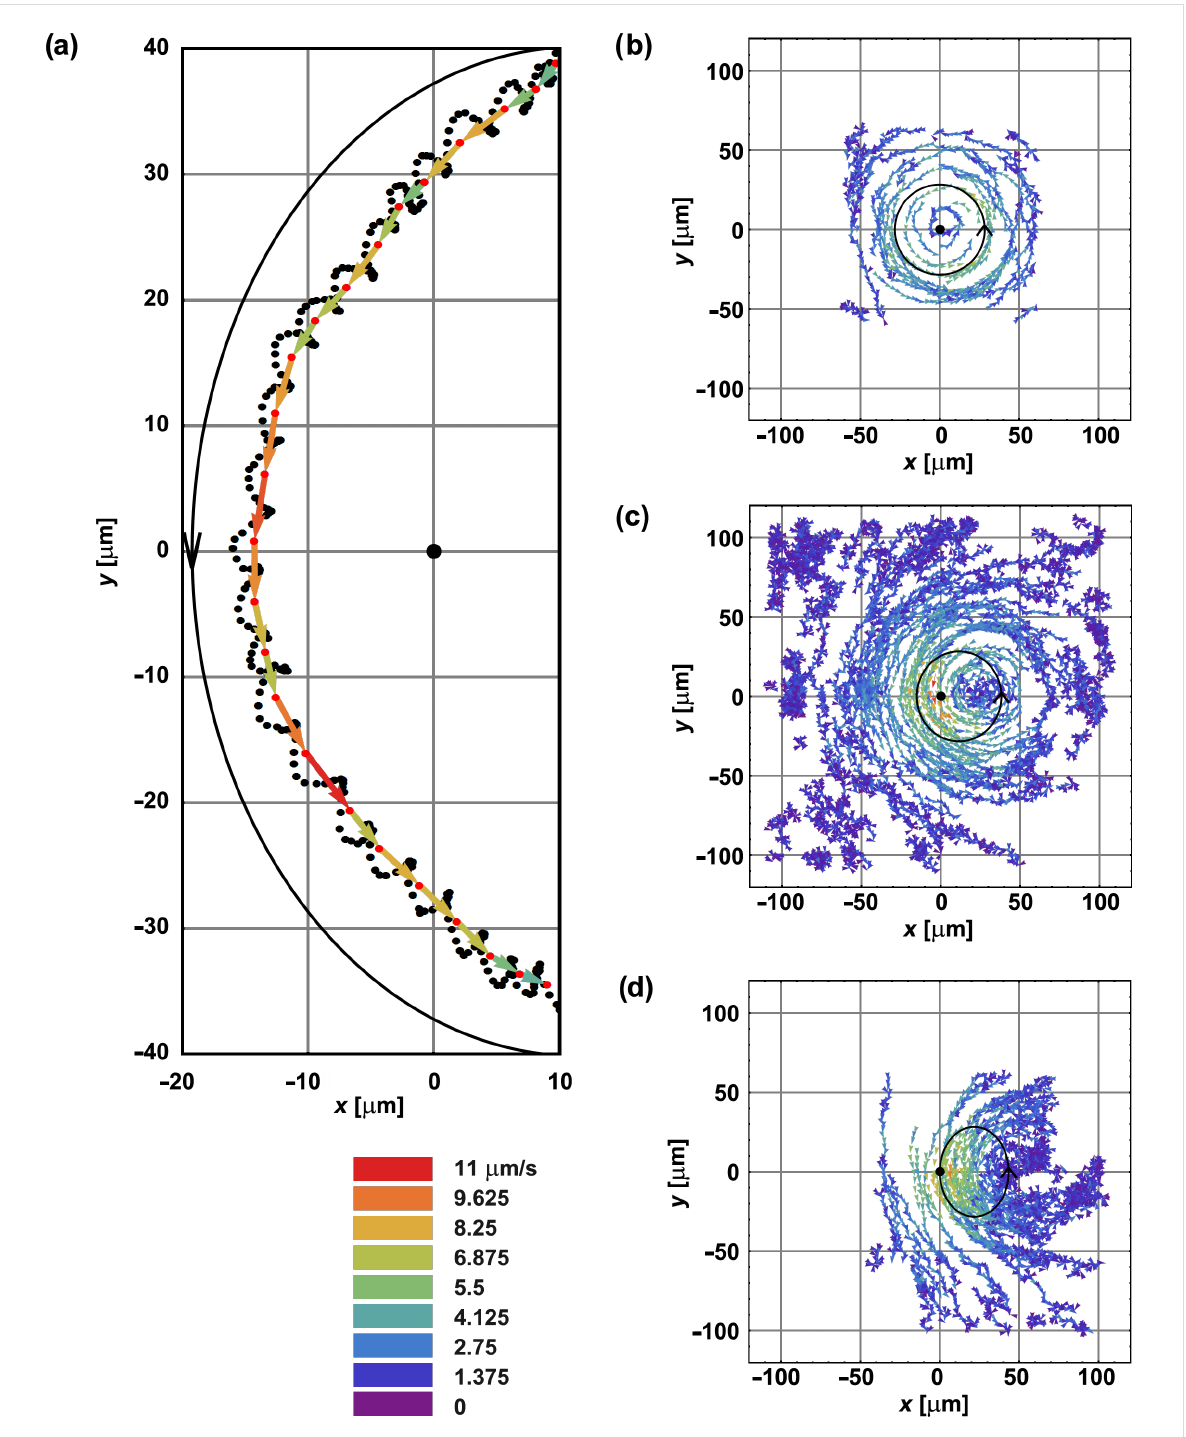
Figure 2: Fluid flow around a beating artificial cilium. The cilium was anchored to the surface at (0,0) and moved along an inverted cone. The calcu- lated path of the tip of the cilium is shown as black closed curve. The flow around it was mapped by using nonmagnetic tracer particles. (a) The pos- ition of the tracer particle (black dots) was recorded every 30 ms. For each cilium cycle, the tracer positions were averaged and the time-averaged positions were obtained (red dots). The displacements between two consecutive red dots are shown as arrows. The colours of the arrows correspond to the velocities. With the rotational motion averaged out, a net translation of the particle is observed, indicating directed pumping of the surrounding fluid. Experimental parameters: Cilium length L = 44 μ m, ψ = 40°, θ = 20°, rotating frequency ω /2 π = 1 Hz, height above the surface z = 57.2 μ m. (b)–(d) Combined traces of particles for three different cone tilt angles: the same data as in [9]. (b) θ = 0; (c) θ = 20°; and (d) θ = 40°. Other para- meters are the same as in